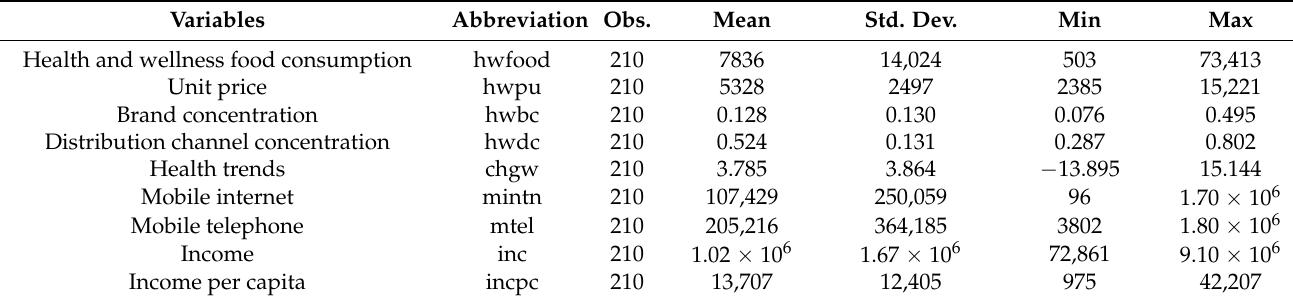
Table 1. Descriptive statistics of estimation model